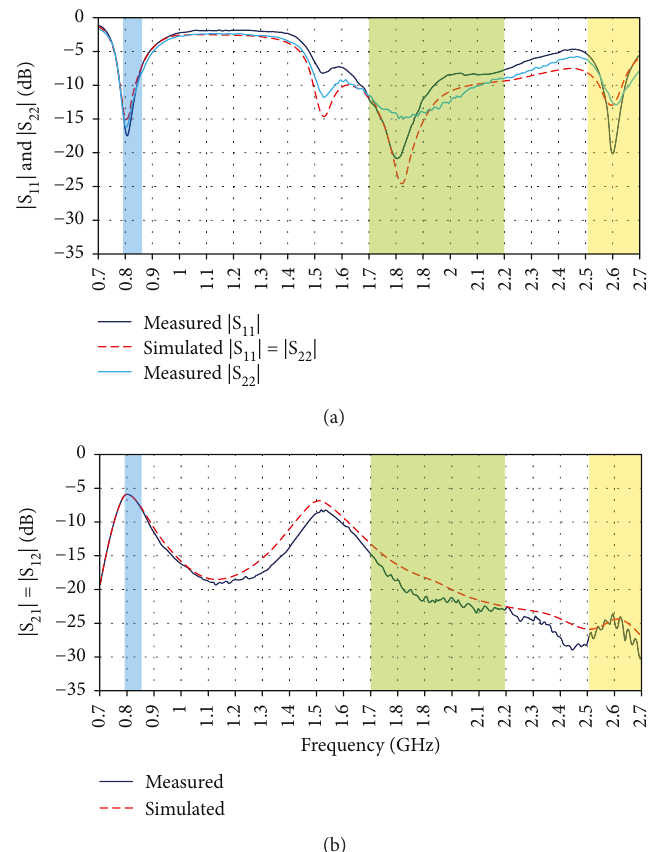
∣ and ∣ S ∣ parameters and (b) measured and simulated ∣ S 11 22